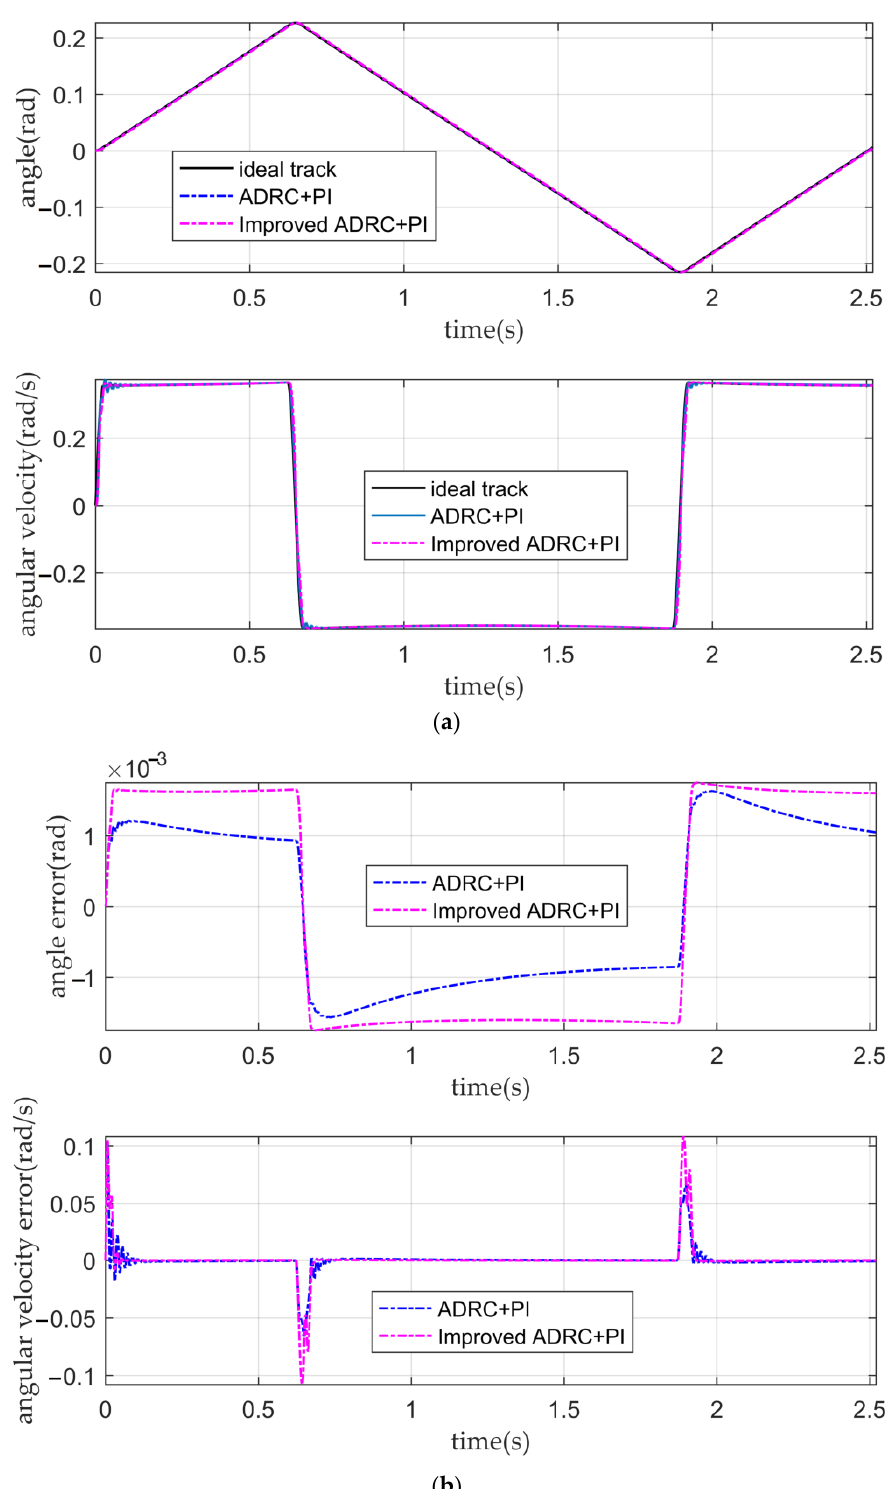
Figure 11. The tracking curves and error curves. ( a ) The angular displacement tracking curves and the angular velocity tracking curves of the conventional active disturbance rejection double closed-loop controller and the IADR-DCLC; ( b ) the angular displacement error curves and angular velocity error curves of the conventional active disturbance rejection double closed-loop controller and the